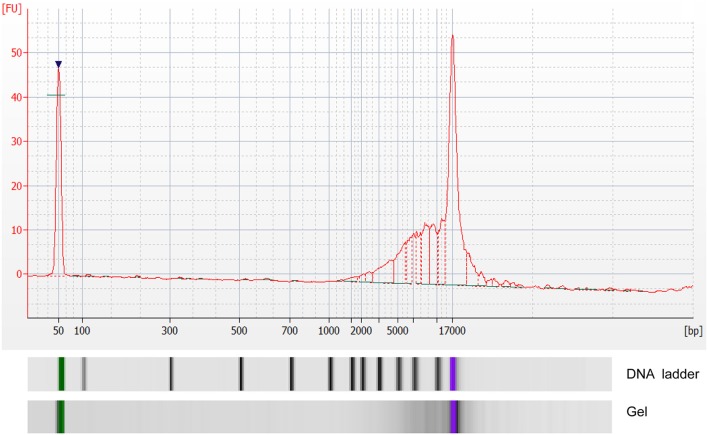
Analysis of double-stranded DNA fragments in exosomes by Agilent 2100 bioanalyzer. X-axis indicated number of base pairs (bp) and Y-axis indicated fluorescence unit (FU).